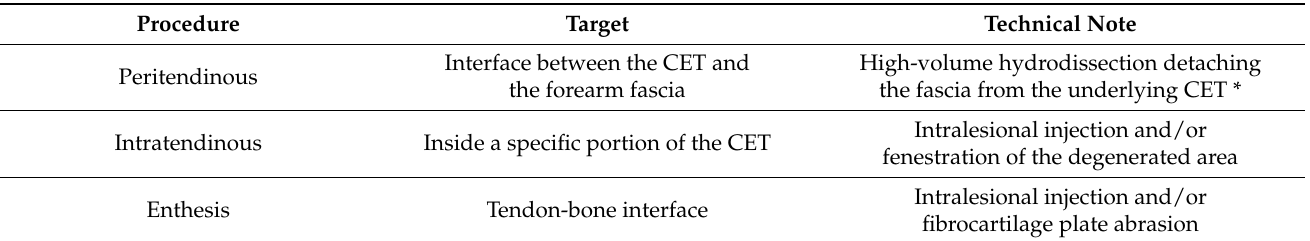
Table 1. USG injections for Lateral